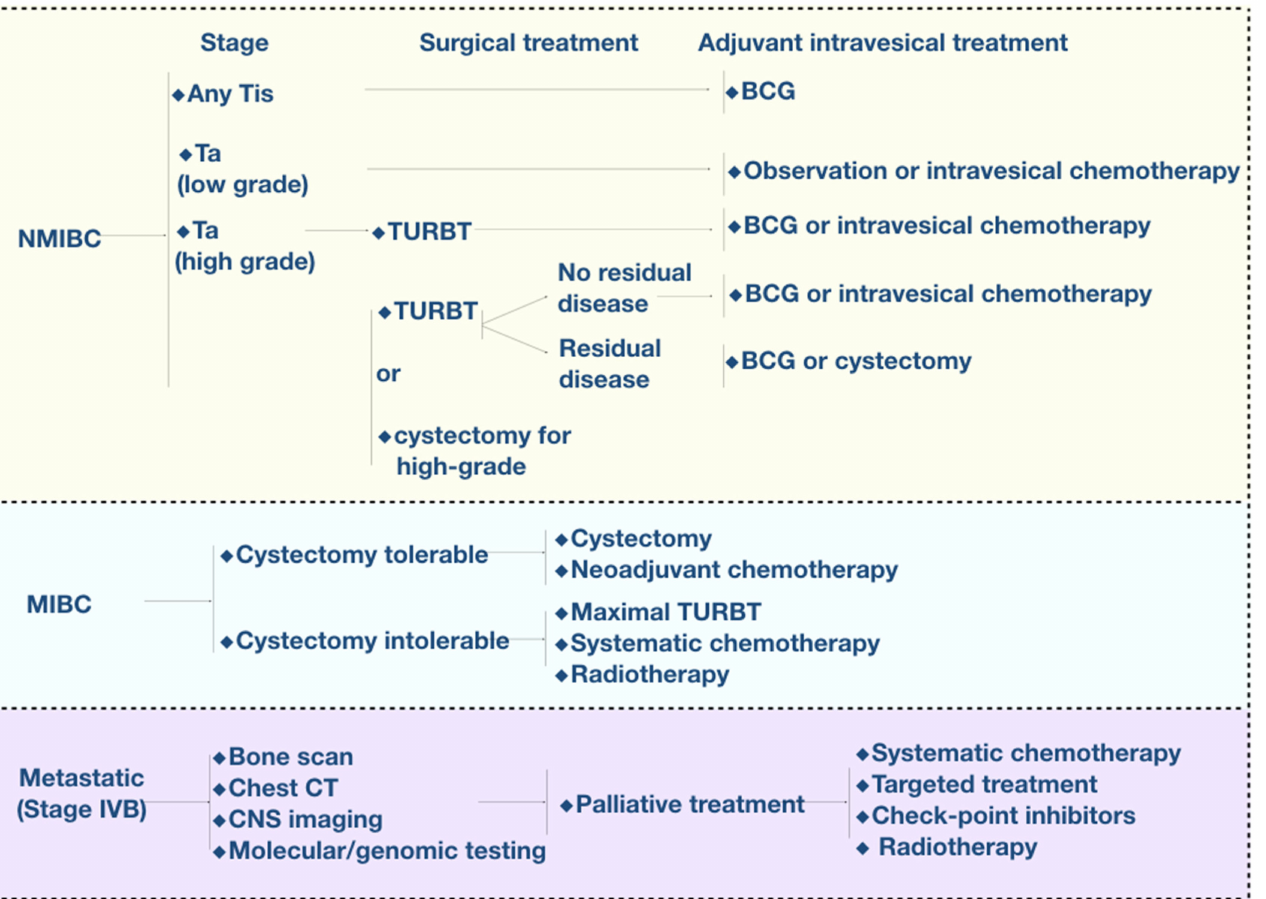
Figure 3. Current therapies of bladder cancer. TURBT: transurethral resection of the bladder cancer; BCG: bacillus Calmette-Guerin; CT: computer